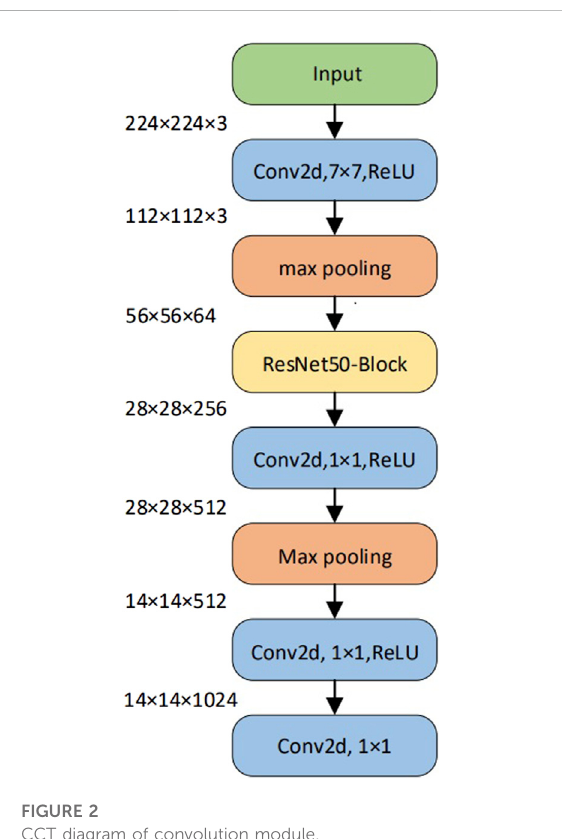
FIGURE 2 CCT diagram of convolution